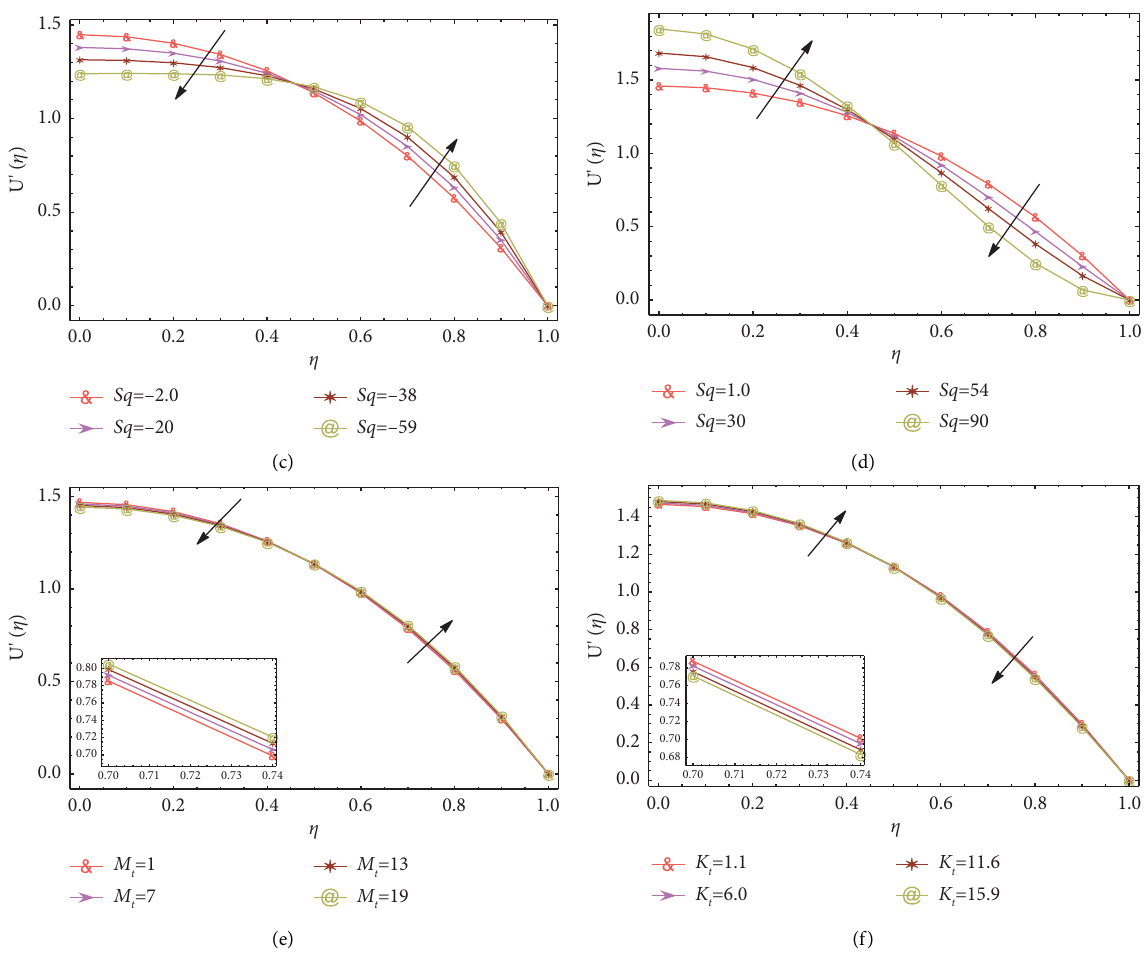
Figure 1: Efect of diferent parameters on normal velocity at α � 0 . 85.